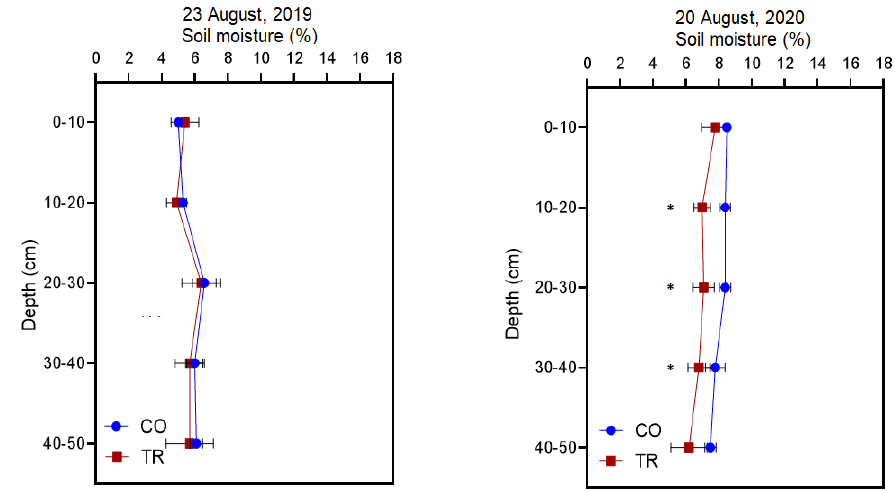
Figure 3. Water content (% w/w ) long the soil profile (0–50 cm) for the TR (with CC) and CO (without CC) systems. Horizontal bars represent the standard error (* = p < 0.05 and ** = p < 0.01).